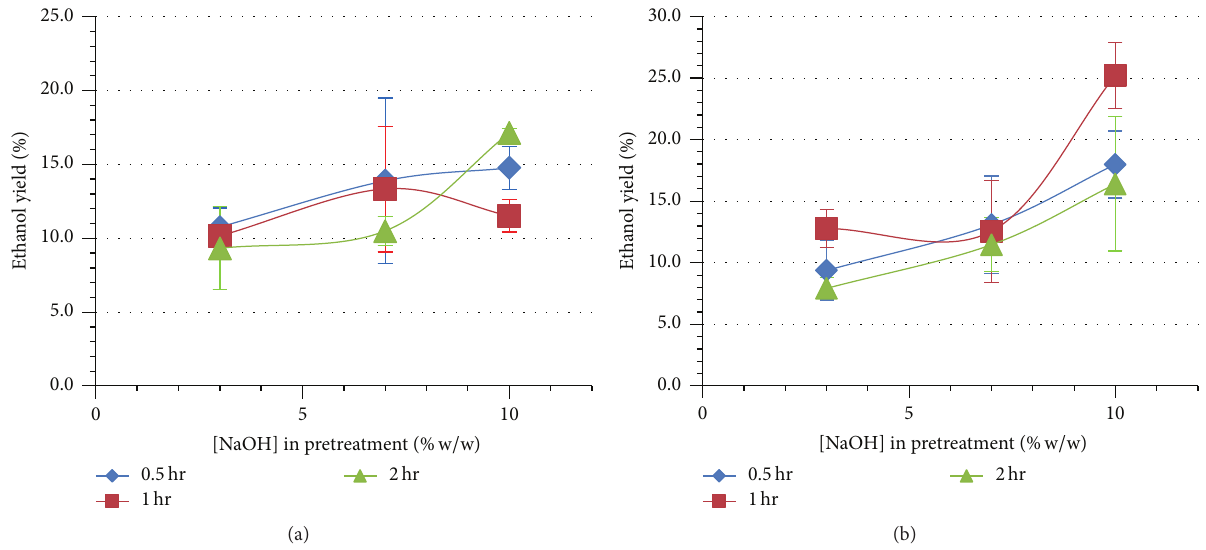
0.05.010.015.020.025.030.035.040.045.050.0